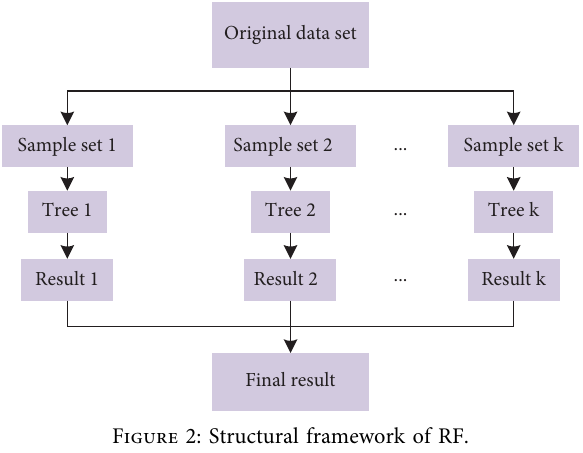
Figure 2: Structural framework of RF.